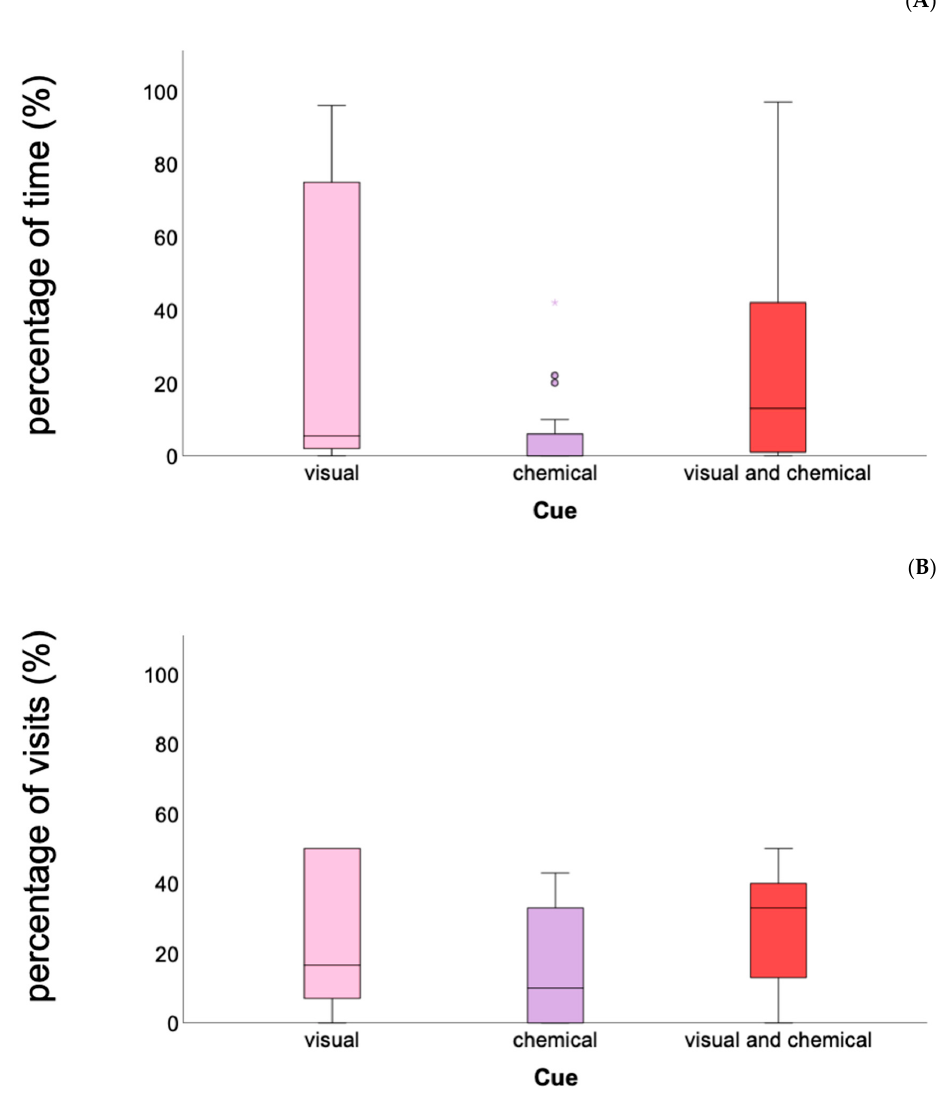
Figure 3. ( A ) Percentage of time (%) spent by the focal fish near the natal shoal; ( B ) Percentage of visits (%) performed by the focal fish to the natal shoal. The boundaries of the box closest to and farthest from zero indicate the 1st and 3rd quartile, respectively; the black line within the box marks the median; whiskers below and above indicate the minimum and maximum value of the data set, respectively; circles indicate outliers; asterisks indicate extremes.